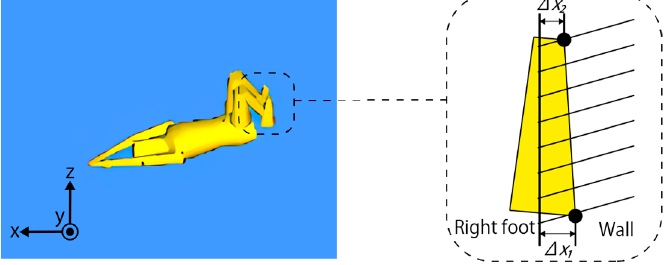
Figure 2. Modeling the contact between both feet and the